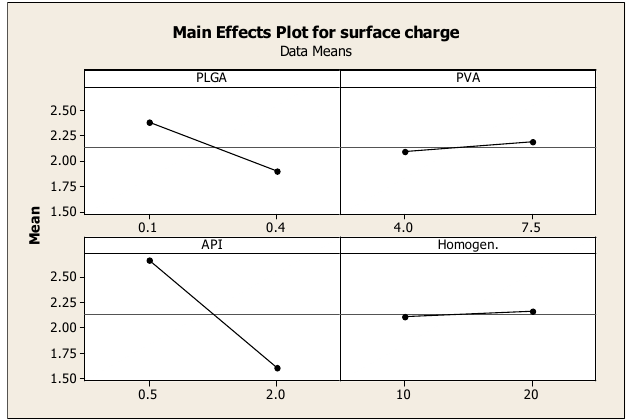
Figure 4. Main effects plot showing the effect of PLGA, PVA, prednisolone concentrations and homogenization time on the Zeta potential of prednisolone nanoparticles.